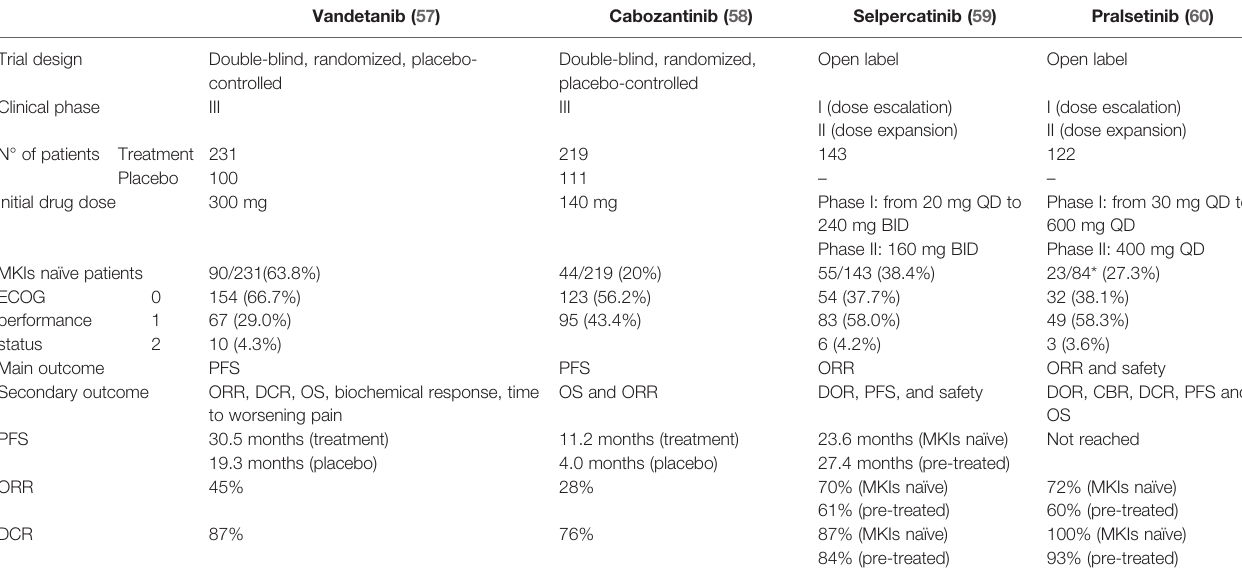
TABLE 3 | Ef fi cacy data of clinical trials evaluating vandetanib, cabozantinib, selpercatinib and pralsetinib treatments in MTC